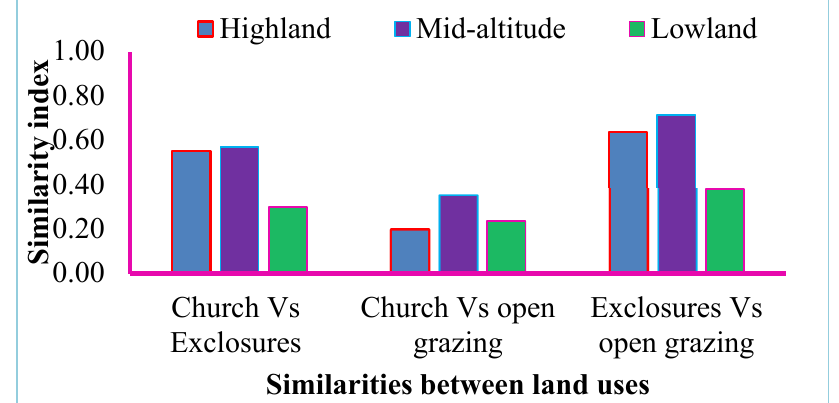
Figure 4. Species similarity index.